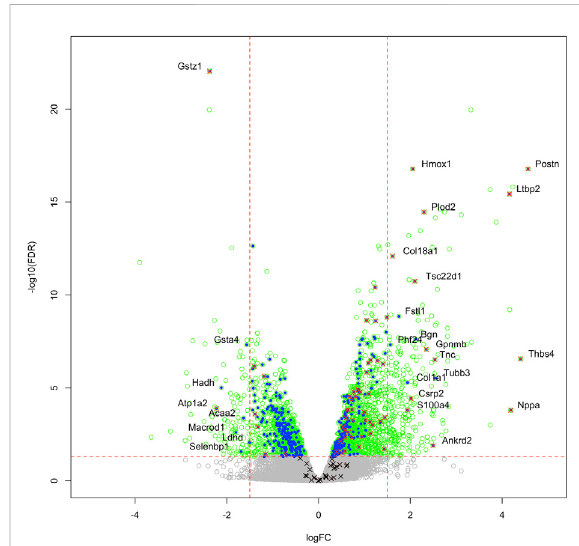
FIGURE 3 Transcriptome and proteome integration: We compared our list of 1,277 signi fi cant proteins to our previously published list of 2,543 signi fi cantly regulated genes (green open circles), identi fi ed in the RVs of an independent cohort of MCT versus Control rats. We identi fi ed an overlap of 410 proteins that are also regulatedatthemRNAlevel(blue fi lledcircles),manyofwhichalso satisfy the z-score cutoff in our proteomic data (red x). Some targets were regulated at the protein level, but not mRNA level (black x). Labelled gene/proteins satisfy a 1.5-fold change cutoff in mRNA and protein expression, respectively.